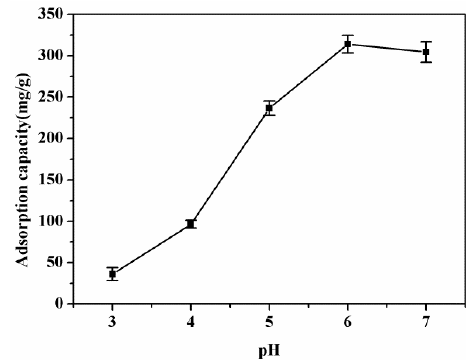
Figure 4. Effect of pH on the adsorption capacity using SPEN-CTAB-0%. Figure 4. E ff ect of pH on the adsorption capacity using